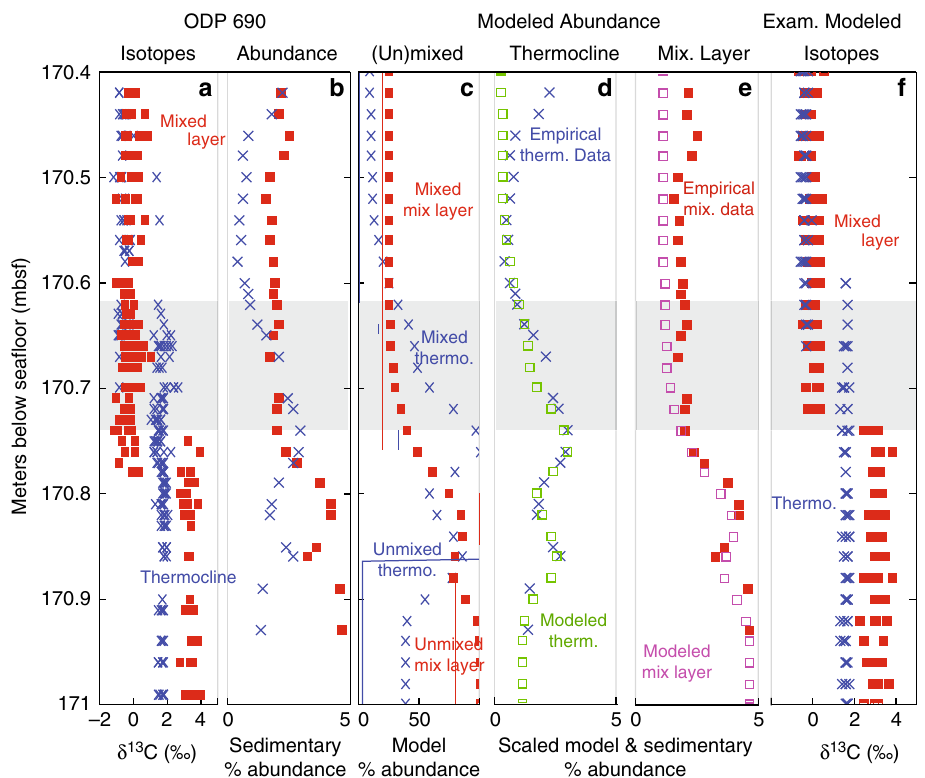
Fig. 5 Sediment model with realistic abundance changes also generates isotope records matching patterns in ODP Site 690 data. a Single-foraminifera isotope data from ODP Site 690 across the PETM exhibit an apparently diachronous step change in mixed-layer planktonic foraminifera δ 13 C ( red ) and thermocline δ 13 C ( blue ) values from ref. 8 . b Sedimentary % abundance of the two relevant genera (thermocline: Subbotina ( blue ) and mixed layer: Acarinina ( red )) varies throughout the interval and can be fi t assuming numerous highs, lows, and gaps in the deposition of the two clades c . Mixed and unmixed populations of mixed-layer and thermocline genera were modeled initially with a maximum abundance of 100%, and then scaled to match the maximum abundance of the empirical thermocline data ( d , blue = empirical data and green = model) and empirical mixed layer data ( e , red = empirical data and pink = model). Once appropriate modeled abundances were obtained, CIE isotope onsets were applied at different depths to determine whether any depth of onset produced isotope records like those of ODP Site 690. An isotope change at 170.74 mbsf did f , with the gray box in each panel highlighting the interval in ODP Site 690 data with apparent delay in isotopic change between mixed layer ( red ) and thermocline ( blue ) individuals, with the lower edge of the box (at 170.74 mbsf) marking the modeled onset of the CIE in the unmixed